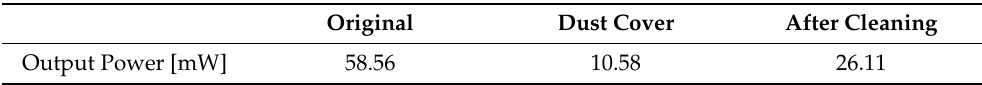
Table 1. Solar energy harvested powers under different